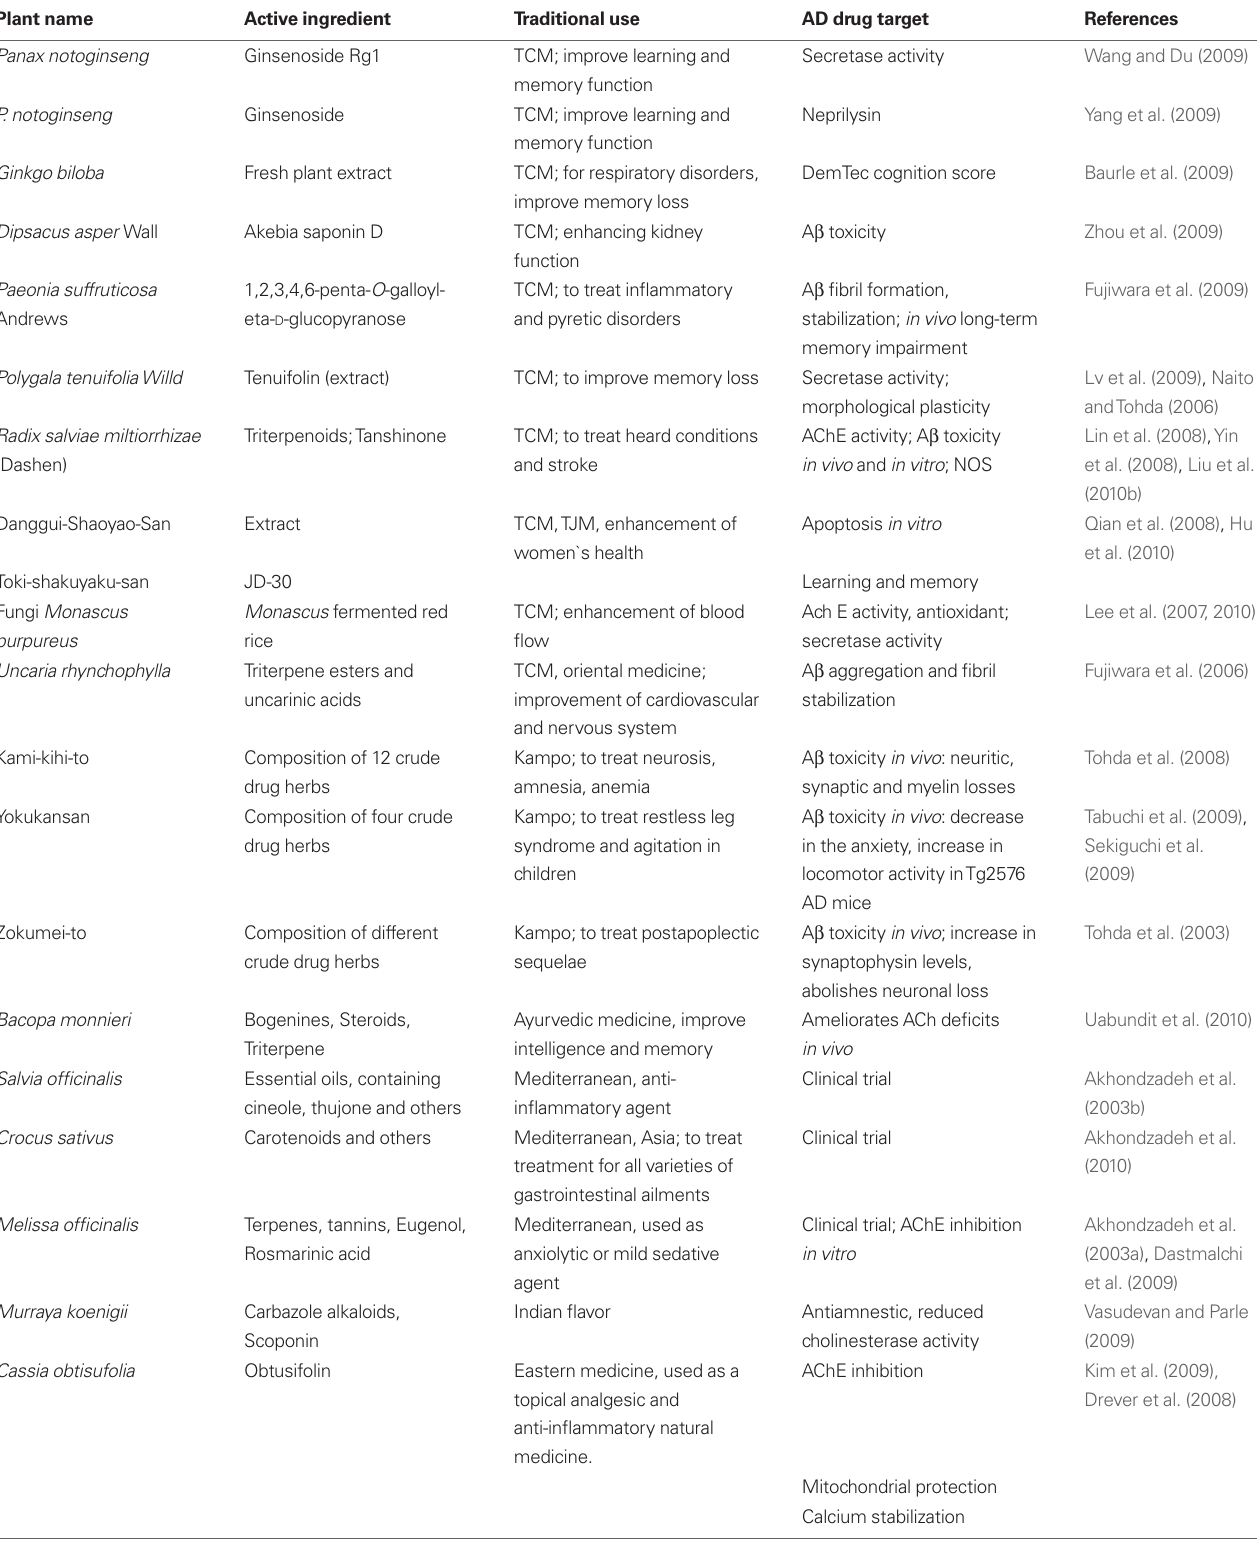
Table 1 | Summary of Plants and its constitutes with traditional use tested recently in vitro , in vivo and in clinical trails for Alzheimer’s disease